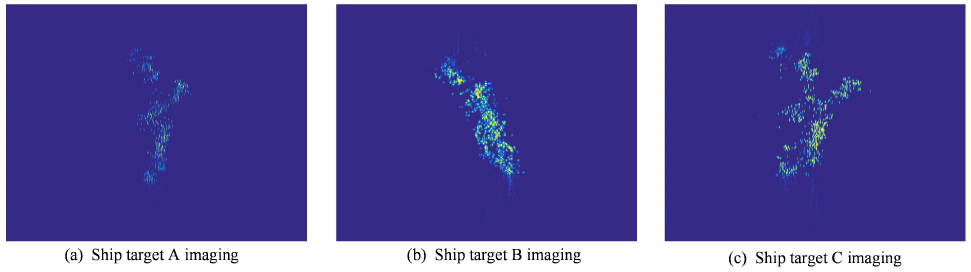
Figure 14. ISAR precise focus imaging